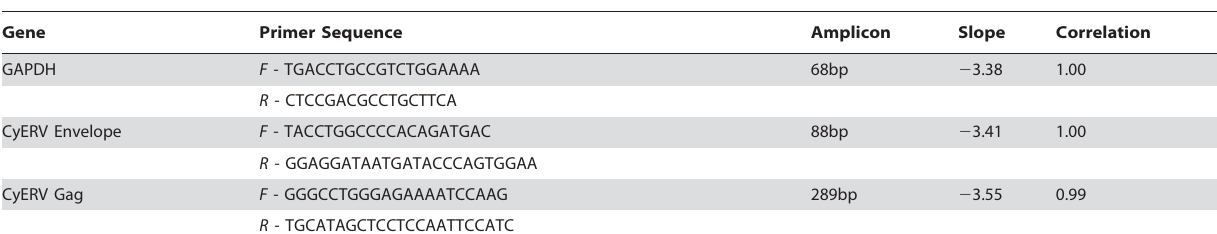
Table 1. RT-qPCR